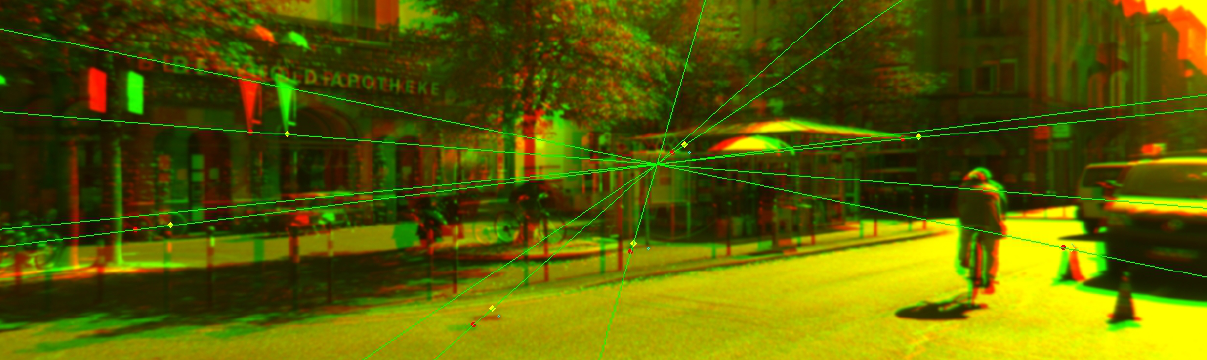
Figure 5: KLT tracker aided by epipolar geometry